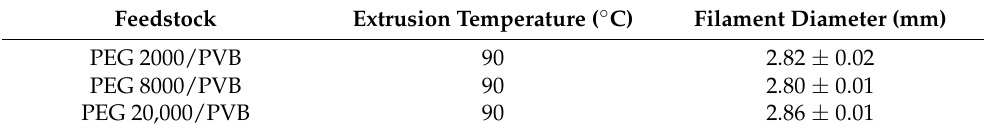
Table 2. Extruded PEG/PVB filaments.